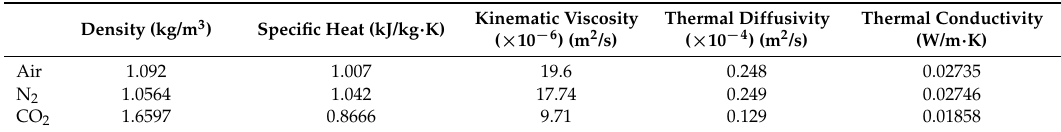
Table 1. The gas medium properties at 50 ◦ C (adapted from [20]).